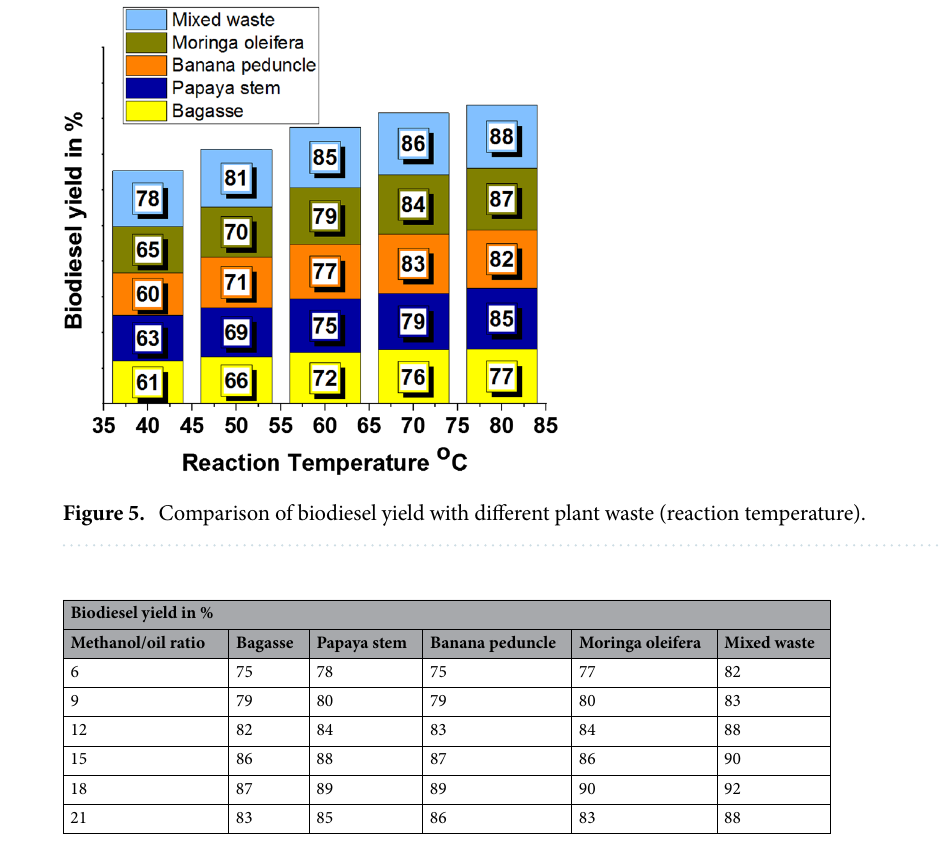
Table 3. Methanol/oil ratio effects in biodiesel